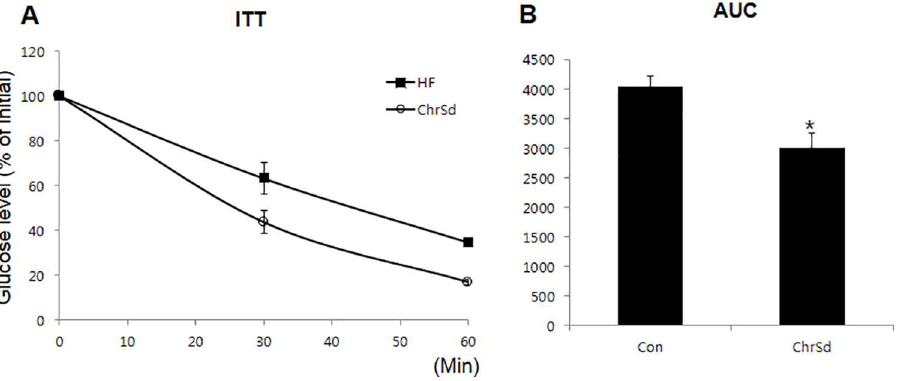
Fig 3. Insulin tolerance in obese mice fed a high-fat (HF) diet supplemented with either 5% microcrystalline cellulose (MCC, control) or 10% (w/w) Chardonnay grape seed flour (ChrSd) for 5 weeks. (A) Insulin tolerance tests (ITTs) were performed in the fasting state. (B) Area under the curve (AUC) values. Data are expressedas mean ± SE. n = 8–9/group. * P <